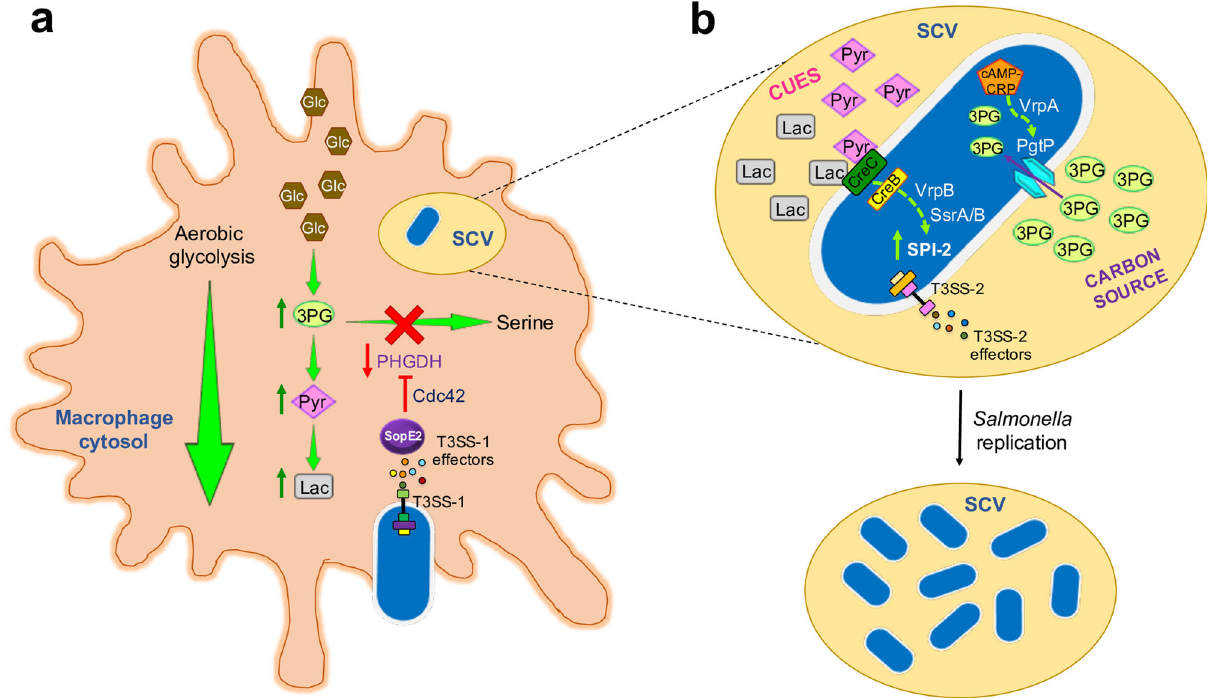
Fig. 1 Salmonella manipulates macrophage metabolism, thus obtaining a carbon source and cues for intracellular replication. a Following infection with Salmonella , macrophages increase the conversion of glucose (Glc) to lactate (Lac) through aerobic glycolysis. Additionally, the SopE2 effector, which is injected by Salmonella into the cytoplasm of host cells by the SPI-1 T3SS (T3SS-1), represses serine synthesis by inhibiting expression of PHGDH via the host cell Rho GTPase Cdc42. Increased aerobic glycolytic fl ux and reduction of serine synthesis prompt the accumulation of host 3-phosphoglycerate (3PG), Lac, and pyruvate (Pyr). b Within the Salmonella containing vacuole (SCV), bacterial replication is supported by the use of host 3PG as a carbon source, while host Lac and Pyr stimulate expression of SPI-2 genes (including those encoding T3SS-2 and effector proteins). In bacteria, the cAMP – CRP complex senses low levels of host Glc and activates the expression of PgtP (3PG transporter) through the VrpA transcriptional regulator. Furthermore, the two-component system CreB/C senses host Lac and Pyr and activates the expression of the VrpB transcriptional regulator, which in turn induces expression of the SsrA/B two-component system, the central positive regulator for